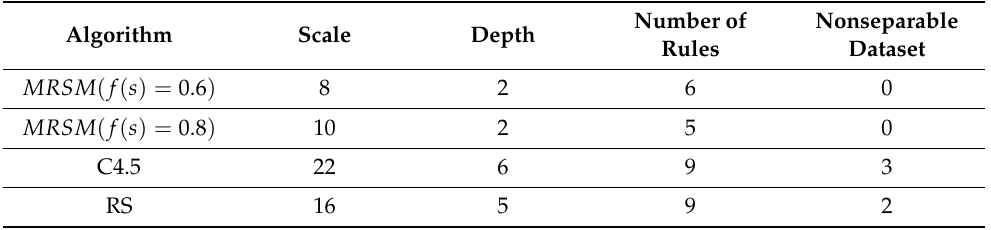
Table 2. Comparison of the decision trees generated by the different